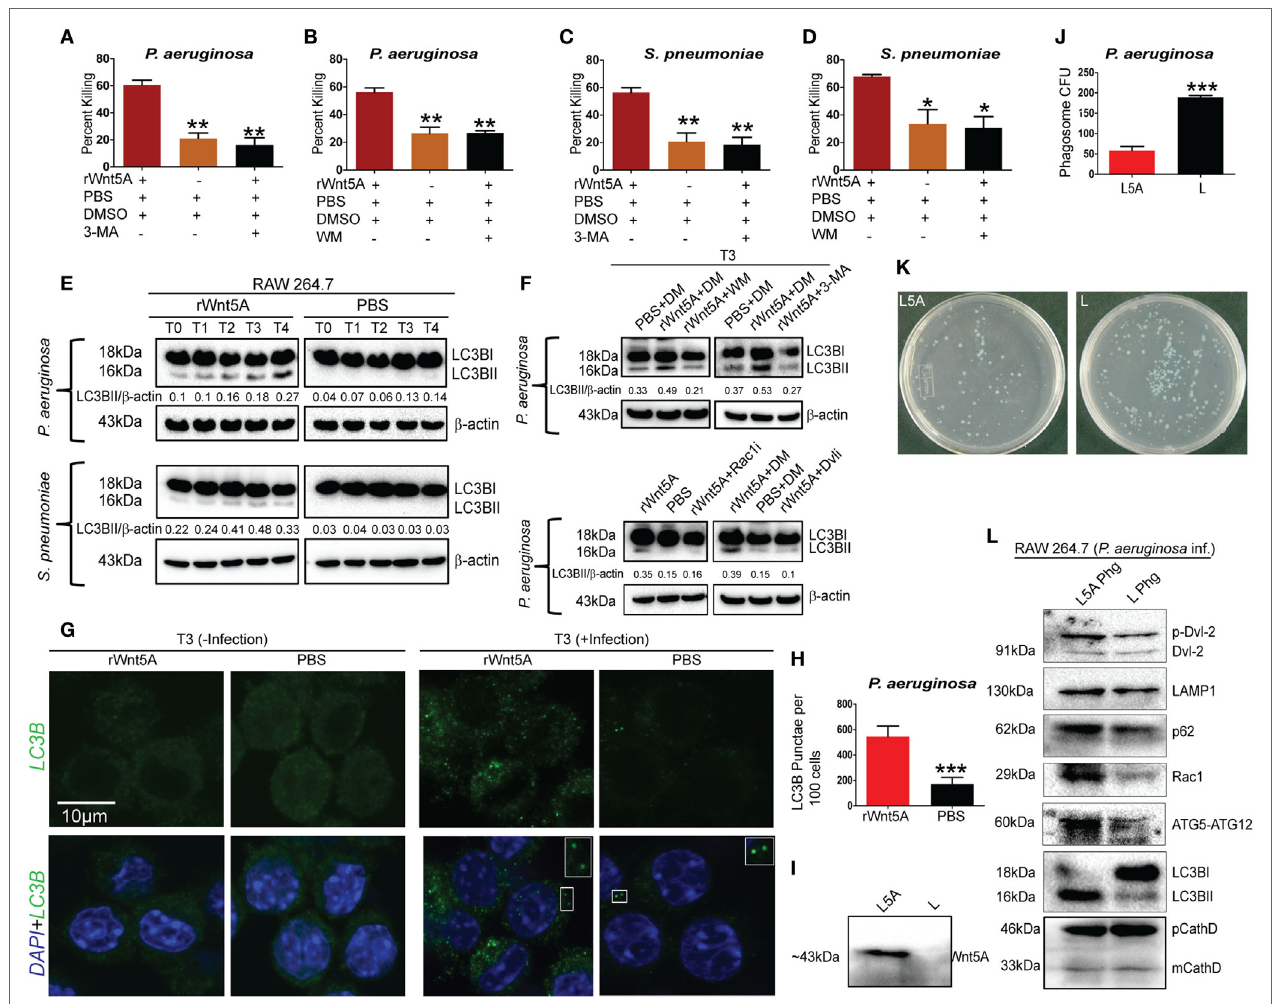
FigUre 5 | Wnt5A-induced bacterial clearance is mediated through autophagy. (a–D) Effect of 3-methyladenine (3-MA, 1 mM) and wortmanin (WM, 100 nM), respectively, on rWnt5A-mediated killing of Pseudomonas aeruginosa (PA) and Streptococcus pneumoniae (SP) ( n = 3). Percent killing was calculated for 3 h (T3) killing time-point. DMSO (DM) and PBS were used as vehicle control. (e) LC3BII accumulation assessed at different killing time-points (T0–T4) for rWnt5A and PBS pretreated RAW 264.7 cells infected separately with PA and SP by western blotting ( n = 3) . T0 represents bacterial killing in 0 time (post 1 h of infection). (F) Influence of WM, 3-MA, Rac1 inhibitor, and Dvl inhibitor (Dvli) on rWnt5A-induced LC3BII accumulation at 3 h (T3) postinfection with PA ( n = 3). (g,h) LC3-punctae in Wnt5A vs. PBS sets as assessed by confocal microscopy (g) and punctae dot calculation (h) ( n = 3). (i) Presence of Wnt5A in L5A conditioned medium (L5A: L cells expressing Wnt5A) but not in L conditioned medium (used as control) ( n = 3). (J,K) Difference in bacterial load between L5A Phg (phagosome isolated from L5A treated cells 2 h postinfection: T2) and L Phg (corresponding control) ( n = 3). (l) Higher levels of LC3BII, ATG5-ATG12, Rac1, p62, LAMP-1, and p-Dvl-2 (phosphorylated Disheveld-2) in L5A Phg compared to L Phg. Both sets contain similar levels of precursor and mature forms of cathepsin D (CathD). Data represented as mean ± SEM; * p ≤ 0.05, ** p ≤ 0.005, *** p ≤